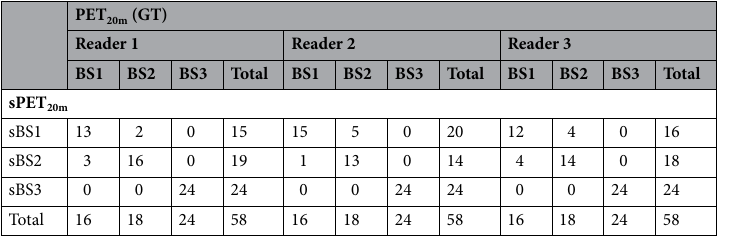
Table 5. Confusion metrics for interpretation of PET images using BAPL score between the PET 20m and sPET 20m images. BS BAPL score of ground truth, GT ground truth, sBS BAPL score of the synthetic PET